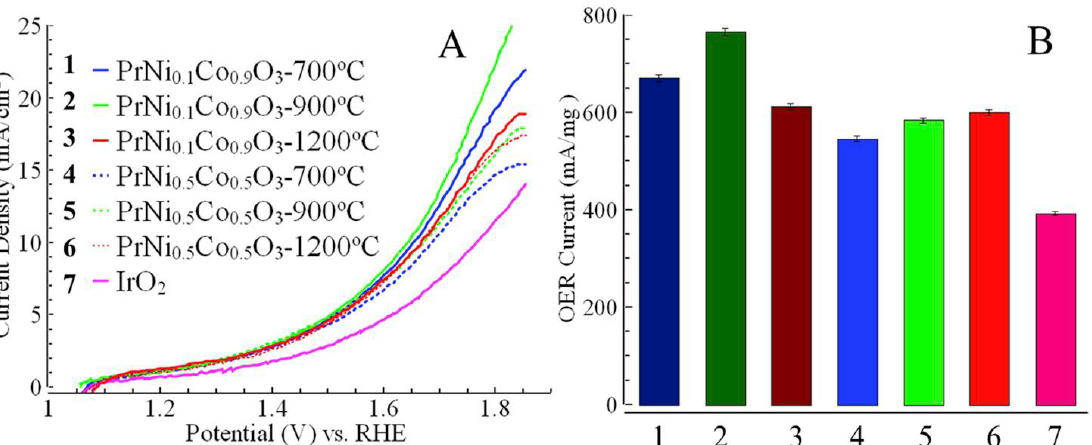
Figure 14. OER performance of PrNi x Co 1 − x O 3 -graphene composite in terms of ( A ) polarization current densities and ( B ) mass activities in comparison to state-of-the-art IrO 2 catalyst. Copyright 2020 by the Elsevier [65].